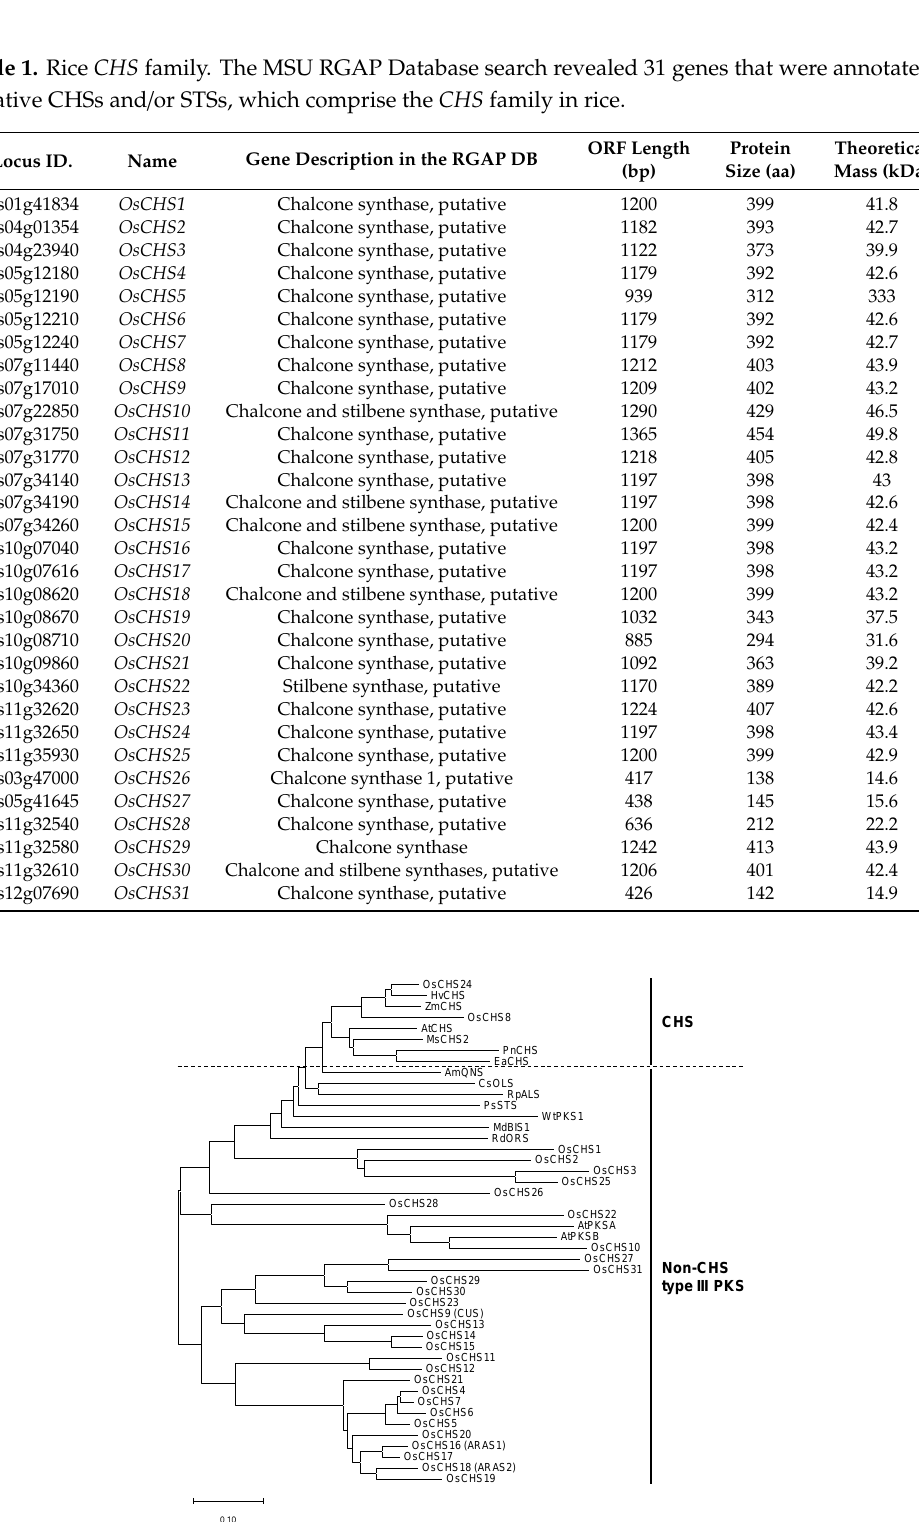
Figure 1. Phylogenetic tree of OsCHSs and other plant CHS family members. The amino acid sequences were aligned with Clustal-W and the neighbor-joining tree was built with MEGA ver. 6. Amino acid sequences used were AtCHS (AAB35812), ZmCHS (NP_001142246.1) EaCHS (Q9MBB1), HvCHS (CAA41250), MsCHS2 (P30074), PnCHS (BAA87922), AmQNS (AGE44110), CsOLS (B1Q2B6), RpALS (AAS87170), PsSTS (CAA43165), WtPKS1 (AAW50921), MdBIS1 (NP_001315967),